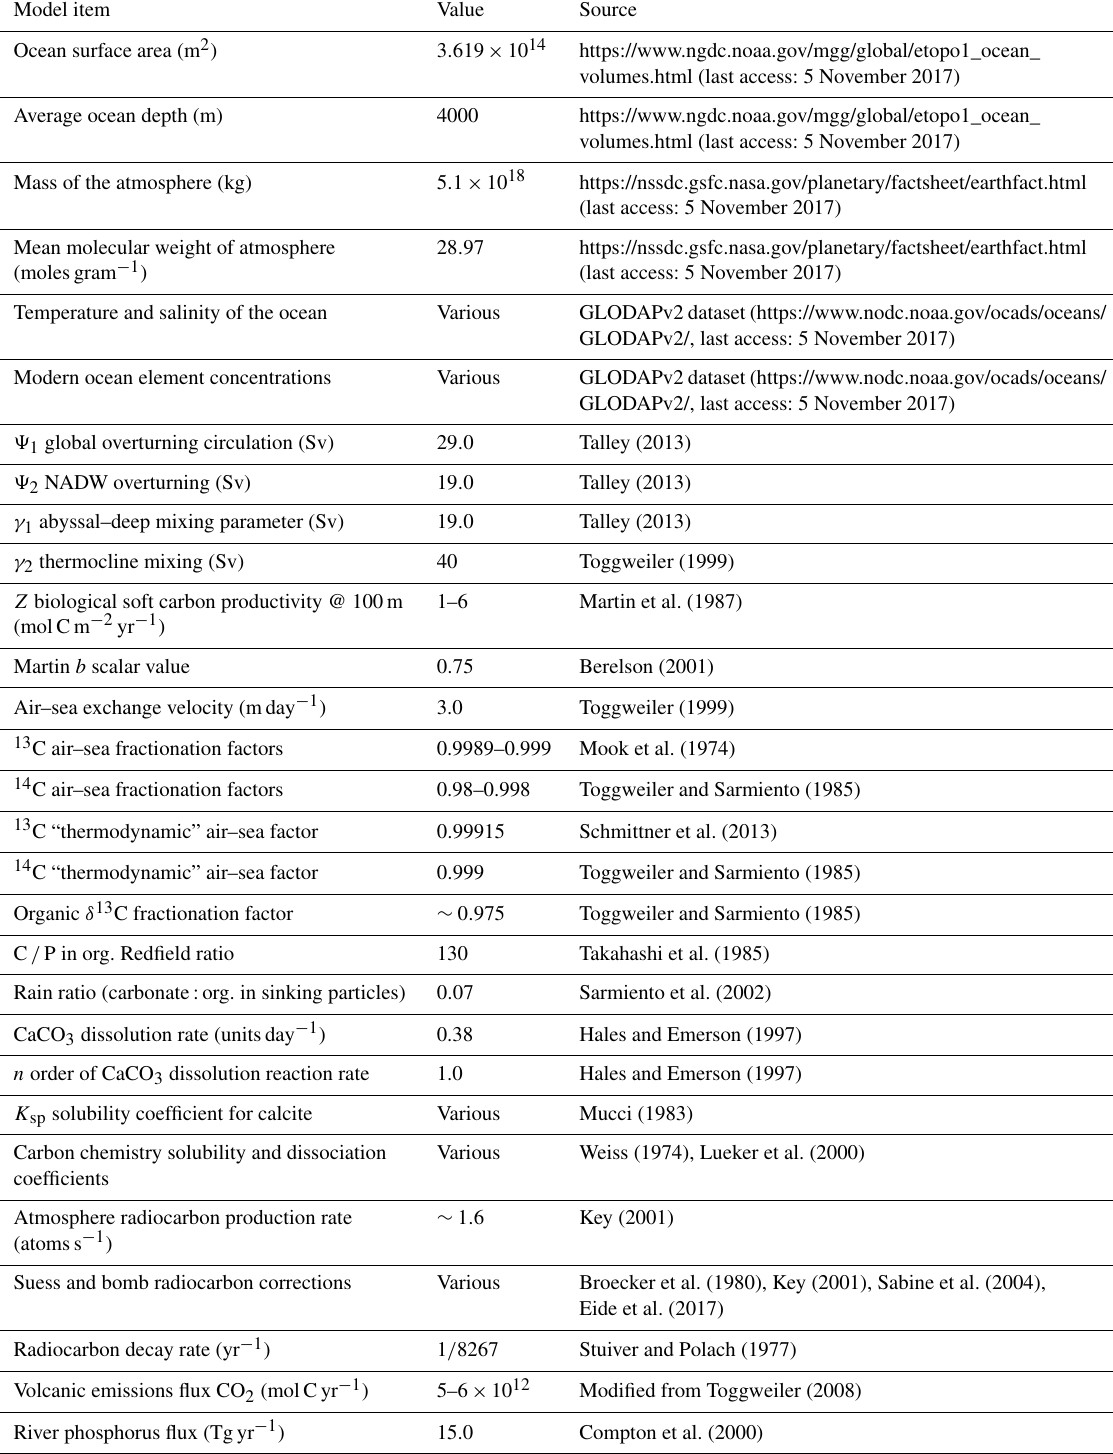
Table A1. SCP-M model dimensions, model parameter starting values and starting data used for model spin-up. Model